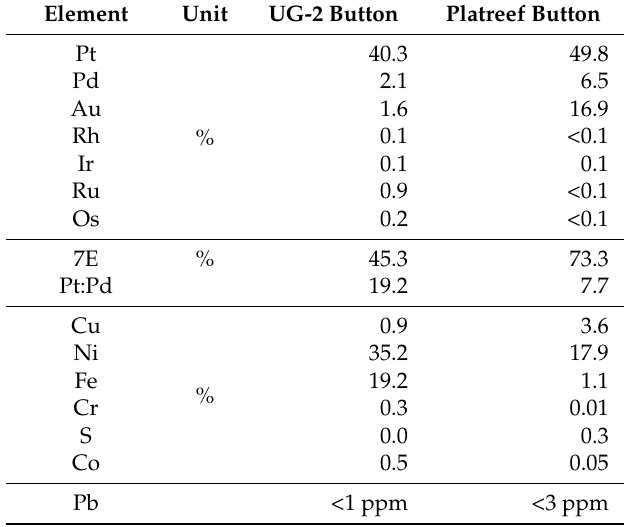
Table 6. PGE and base metal contents of the prills produced during the smelting process.